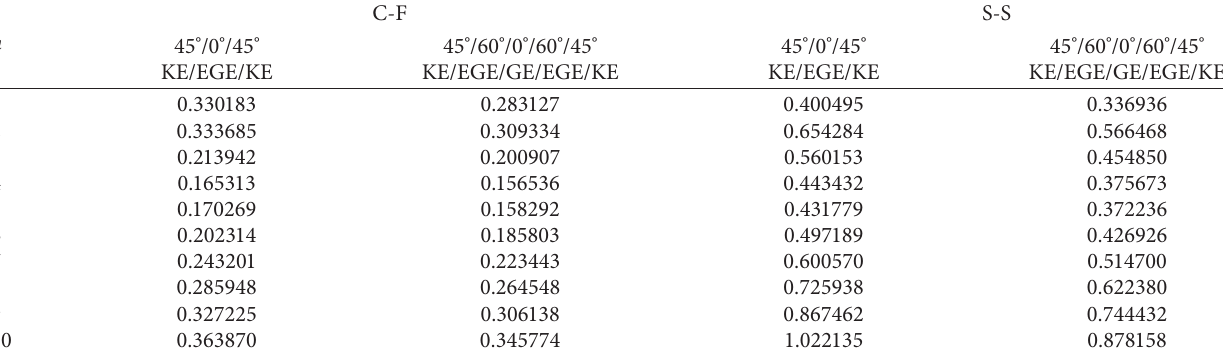
Table 1: Influence of circumferential node number on the fundamental frequency parameter of three- and five-layered conical shells with KE/EGE/KE and KE/EGE/GE/EGE/KE material combinations.